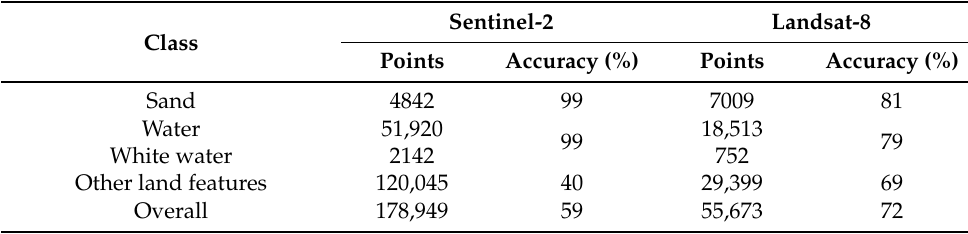
Table 2. Classification accuracy for the application of the presented algorithm in the dataset by Vos et al. [9]. Sentinel-2 Landsat-8 Class Points Accuracy (%) Points Accuracy